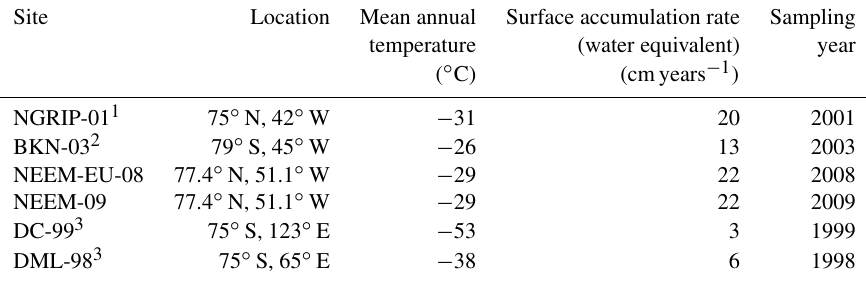
Table 1. Site information on the drilling locations of the North Greenland Ice core Project (NGRIP-01 Ishijima , NGRIP-01 Bernard ) , Berkner Island (BKN-03), the North Greenland Eemian Ice drilling Project (NEEM-EU-08, NEEM-09), Dome Concordia (DC-99) and Dronning Maud Land (DML-98), where firn air samples were collected, and two key meteorological variables of each